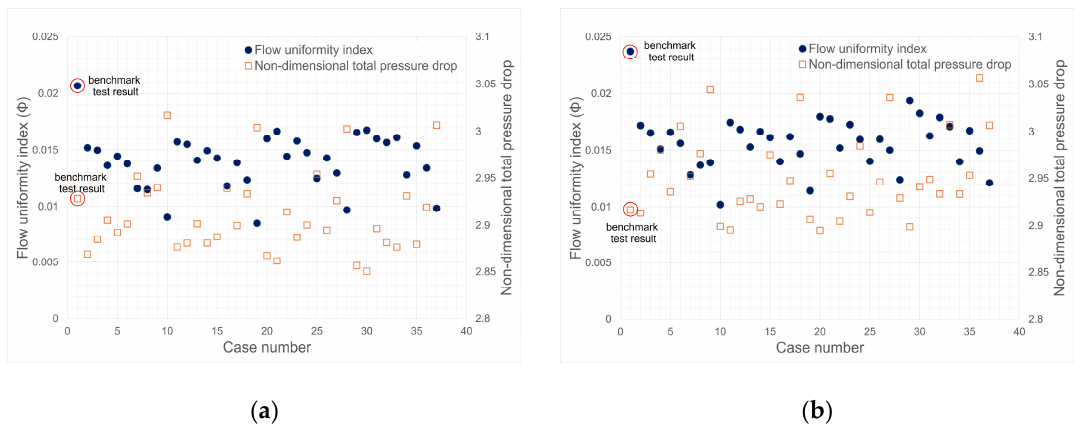
Figure 10. Flow uniformity index and non-dimensional total pressure drop for the parameter studies of novel designs: ( a ) U-type; ( b ) Z-type. of novel designs: ( a ) U-type; ( b )